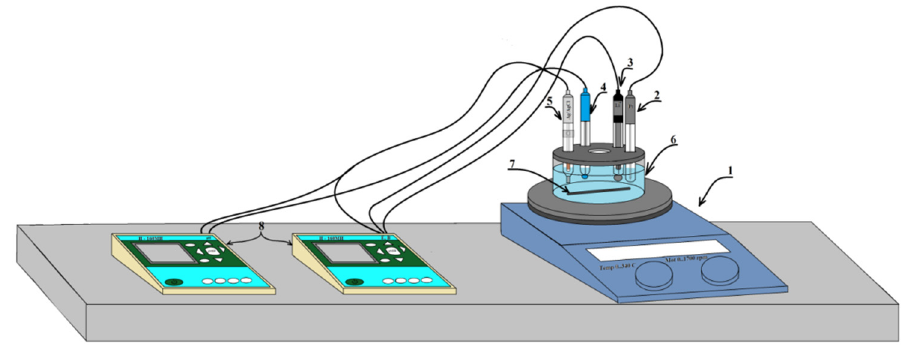
Figure 6. Schematic illustration of the oxidation equipment. 1—magnetic stirrer; 2—platinum electrode; 3—Li selective electrode; 4—pH glass electrode, 5—Ag/AgCl electrode; 6—glass cell; 7—stirrer; 8—ionometer.